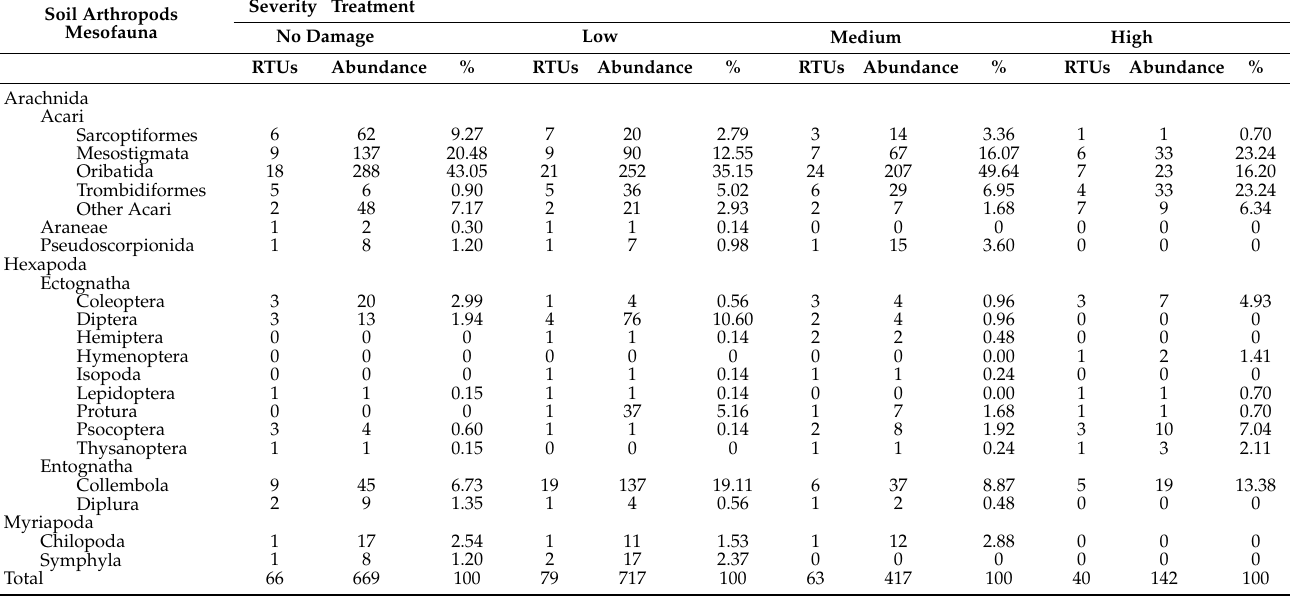
Table 1. Total abundance of soil arthropods mesofauna per